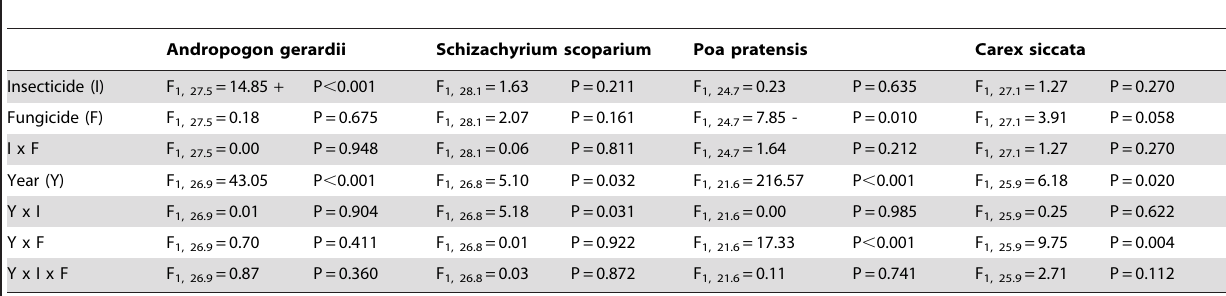
Table 1. The effects of insecticide, fungicide, and year on total seed production for the four graminoid species ( + positive main effect of treatment; - negative main effect of